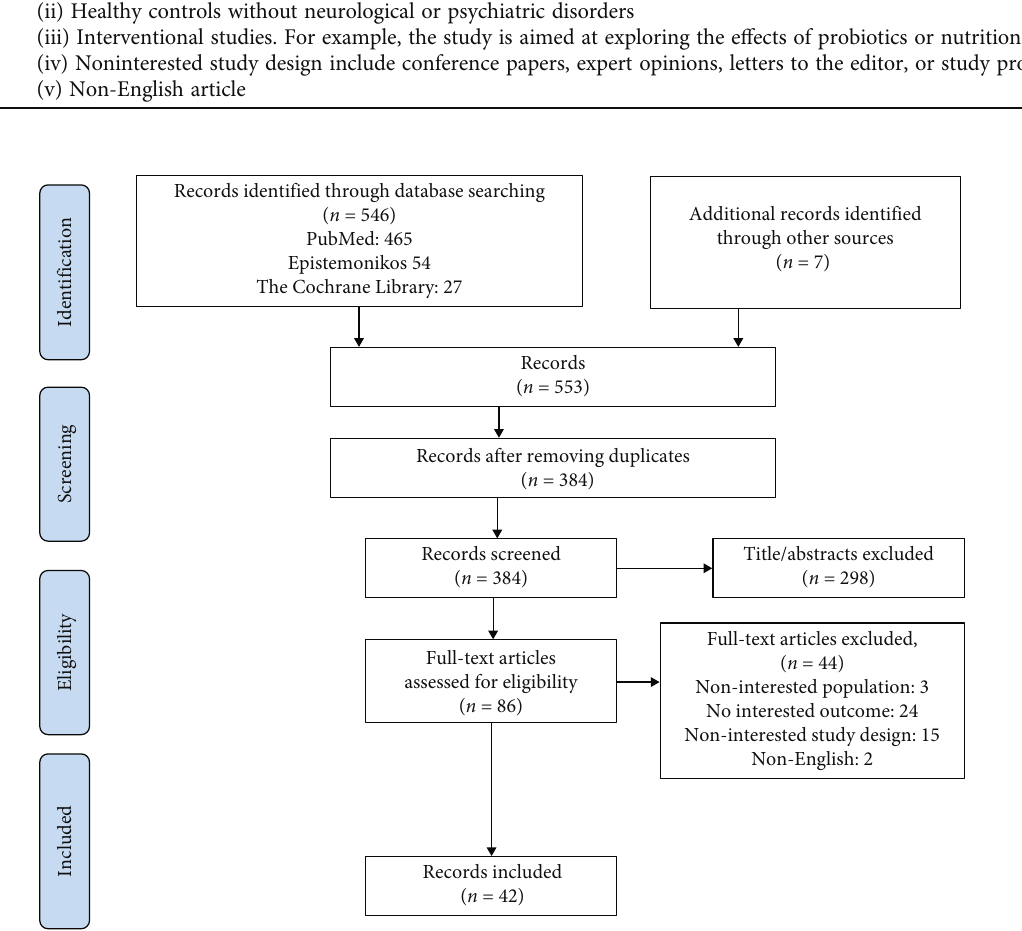
Figure 1: PRISMA fl ow diagram of the studies